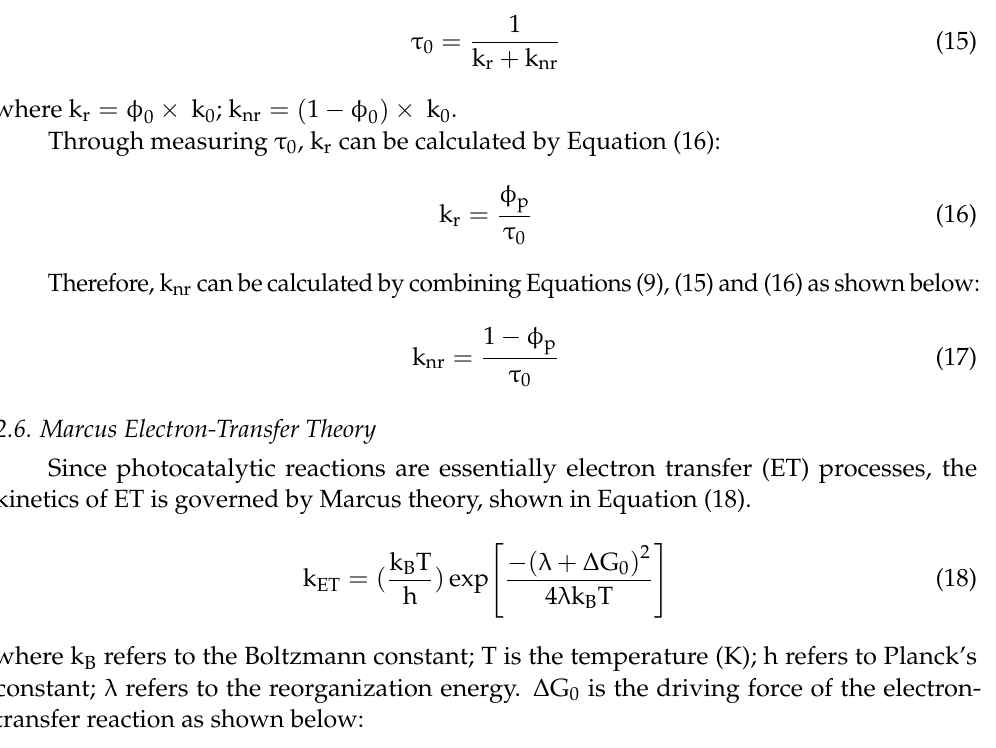
Figure 3. Jablonski diagram of a typical metal-based photosensitizer. Adapted with permission from ACS Energy Lett. 2019, 4, 2, 558–566. Copyright 2019 American Chemical Society. Generally, the lifetime ( τ 0 ) of a photosensitizer is measured by excited-state transient absorption (TA) spectra and the signal fit to single [24] or triple [26] (depends on the mechanism of photosensitizers) exponential decay kinetics. To complete a photocatalytic reaction, the excited-state lifetime must be long enough to overcome the decay